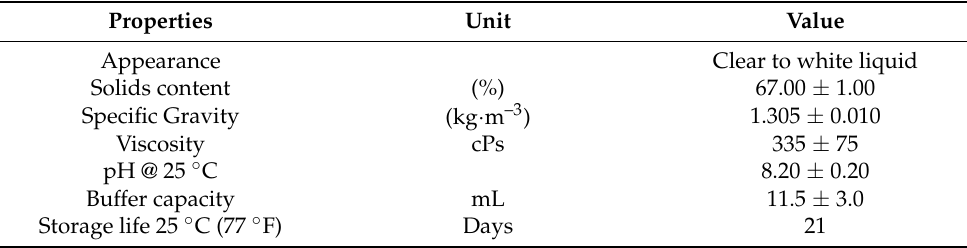
Table 1. Properties of urea formaldehyde